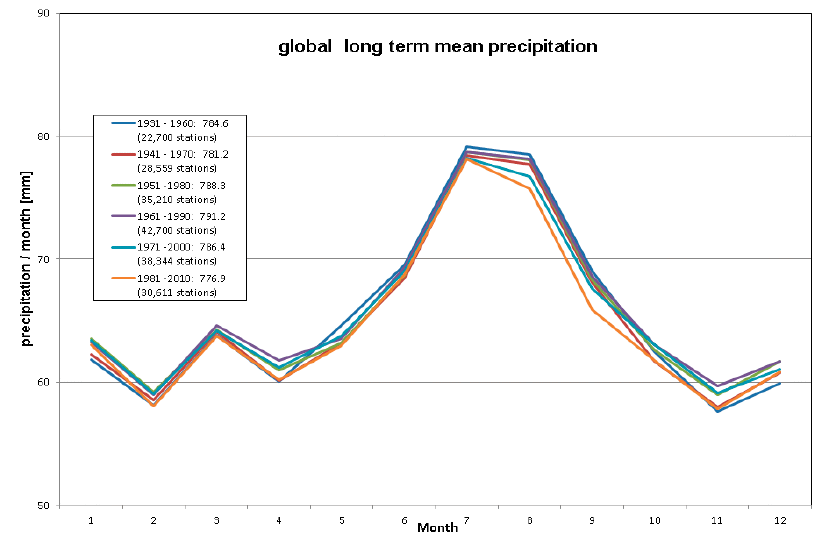
Figure 7. Mean annual cycle over the global land surface for the different 30-year reference periods